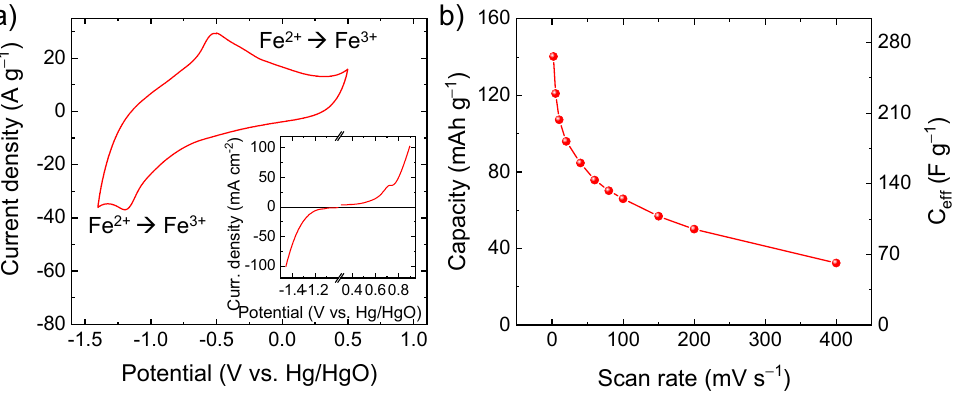
Figure 4. ( a ) CV curve of the C-Fe 2 O 3 -based electrode in 6 M KOH (potential scan rate = 100 mV s − 1 ). The inset shows the LSV analysis of the electrode, indicating the onset potential of irreversible water splitting reaction (potential scan rate = 2 mV s − 1 ); ( b ) capacity and C eff of the C-Fe 2 O 3 -based electrode as a function of the potential scan rate.